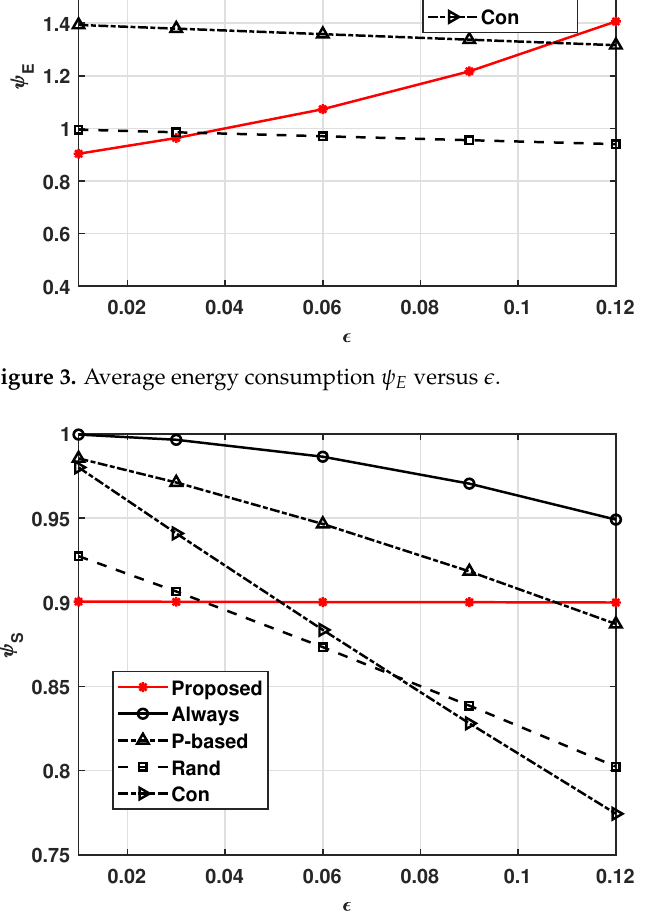
Figure 4. Successful task computational probability ψ S versus (cid:101)